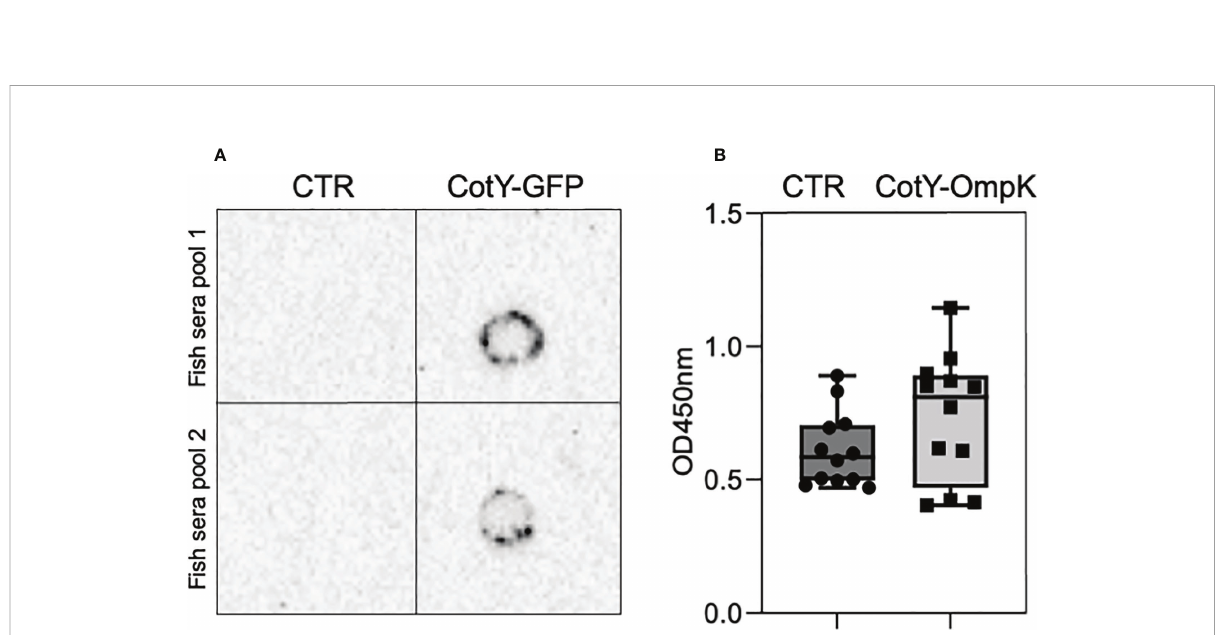
FIGURE 4 European seabass serum antibodies upon oral vaccination with OmpK and GFP carrying spores. Detection of anti-GFP (A) and anti- V. anguillarum (B) antibodies in the serum of orally vaccinated European seabass juveniles. Detection of anti-GFP antibodies (A) was done in 2 pools of 6 fi sh (2 fi sh from each tank of each experimental treatment) by Dot-Blot using puri fi ed GFP and an anti-GFP antibody. Detection of anti- V. anguillarum antibodies (B) was done by indirect ELISA in the sera of individual fi sh (n=12) using V. anguillarum cell-extracts and anti- seabass antibody. Data are represented as mean ± standard deviation